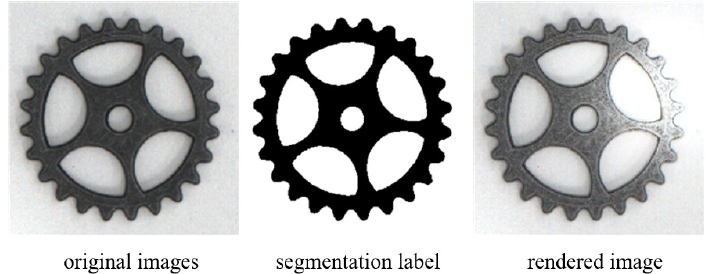
Figure 4. Examples from the dataset. The first image was taken in the ideal environment, which achieved the best imaging result; the second image has the foreground and background manually marked, which can be used as the label of image semantic segmentation; last is the image with interference factors collected in the simulated industrial environment as the input of our